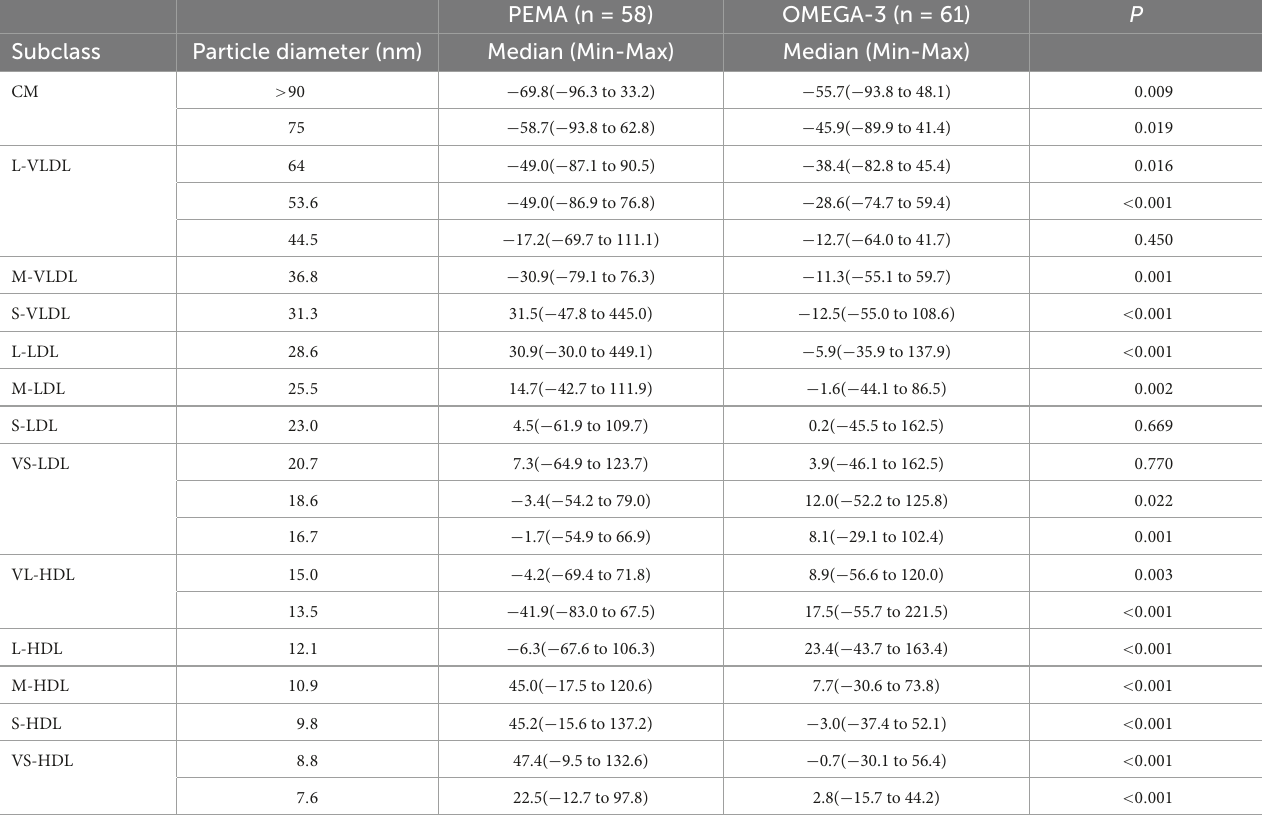
TABLE 5 Percentage changes in cholesterol content by GP-HPLC analysis from baseline to week